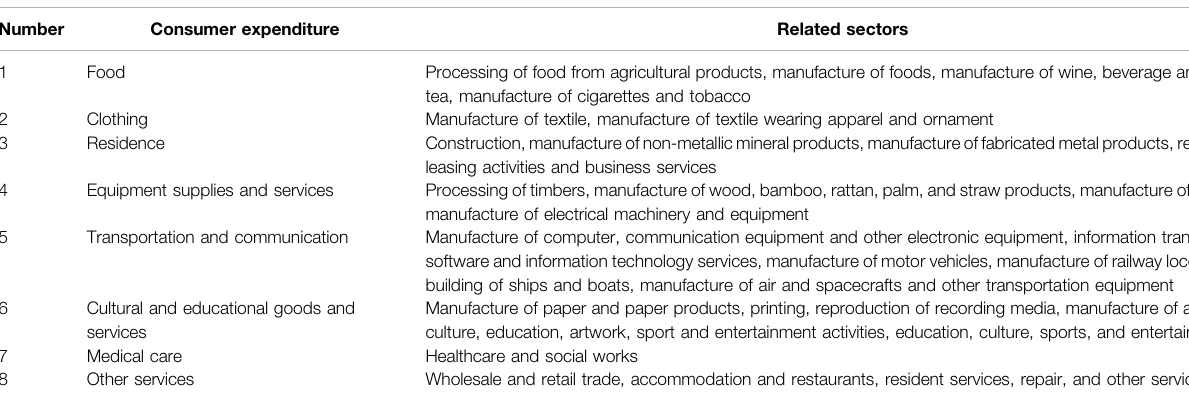
TABLE 3 | Related sectors of consumer expenditure.